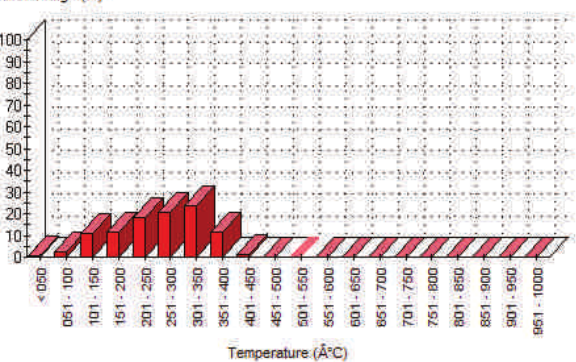
Fig. 1. Exhaust gas temperature profile of an intercity bus (in degrees